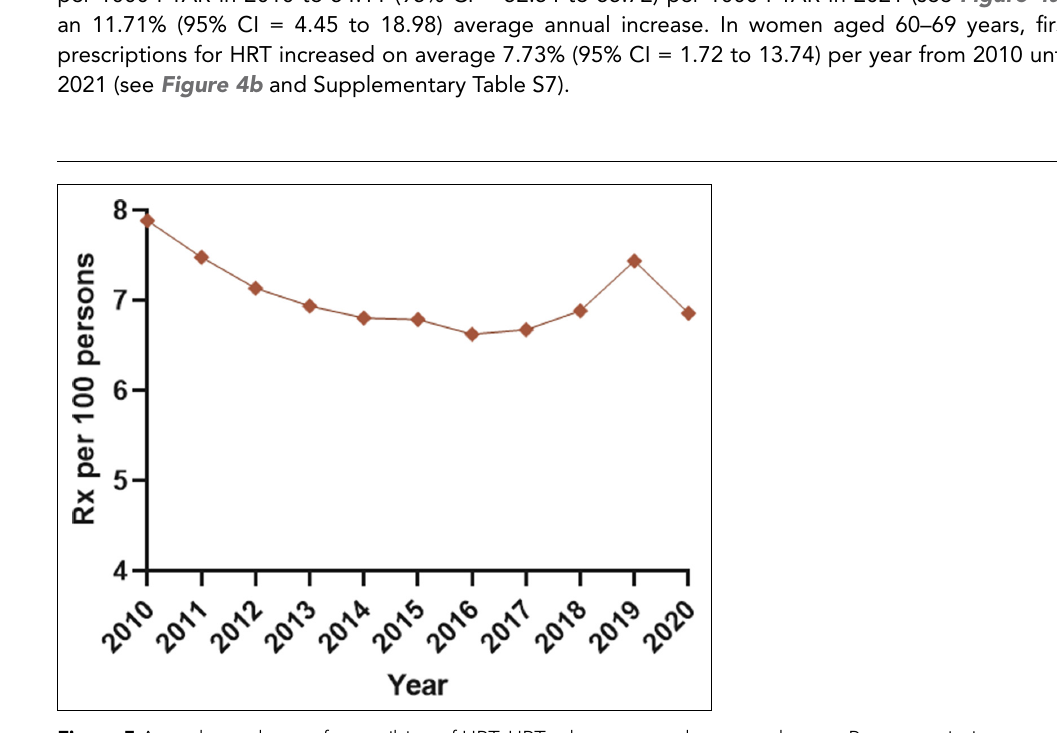
Figure 5 Annual prevalence of prescribing of HRT. HRT = hormone replacement therapy. Rx =